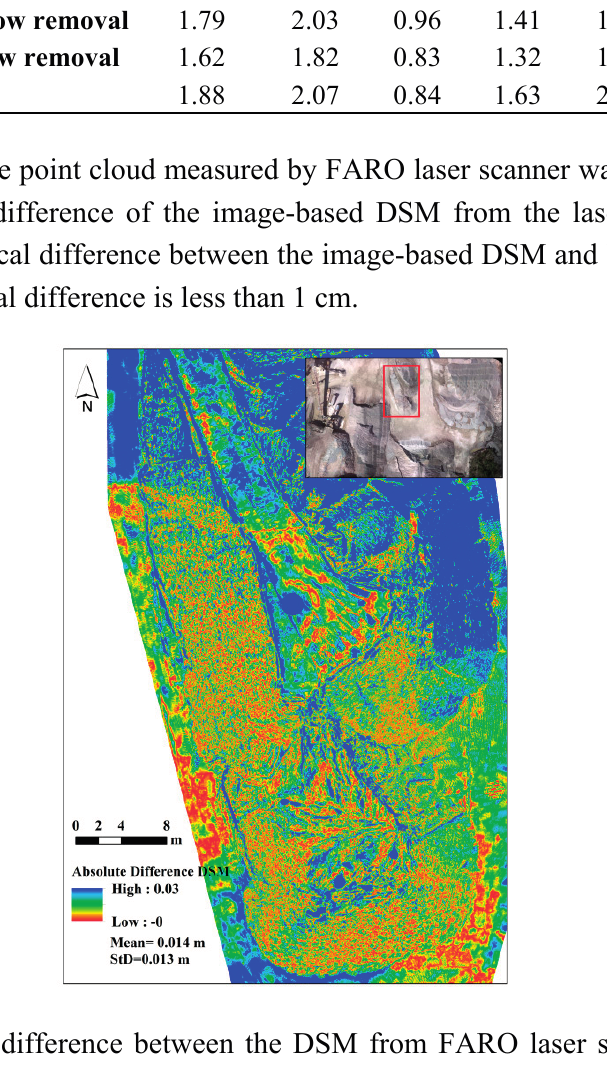
Figure 19. Absolute difference between the DSM from FARO laser scanner and that of dataset